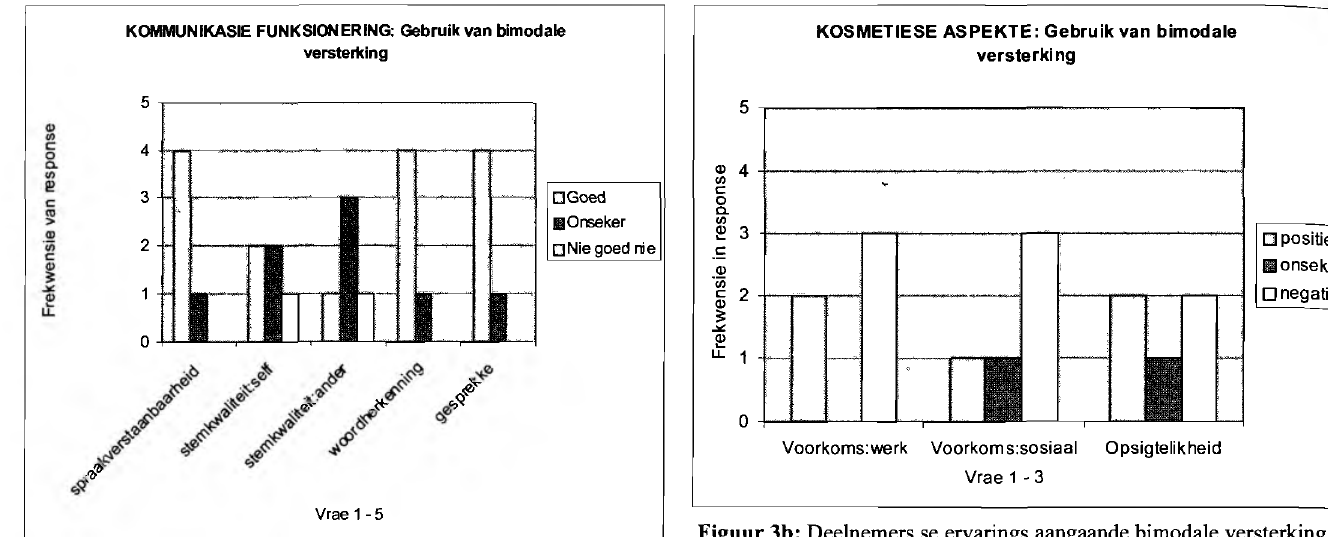
Figuur 3b: Deelnemers se ervarings aangaande bimodale versterking in terme van kosmetiese